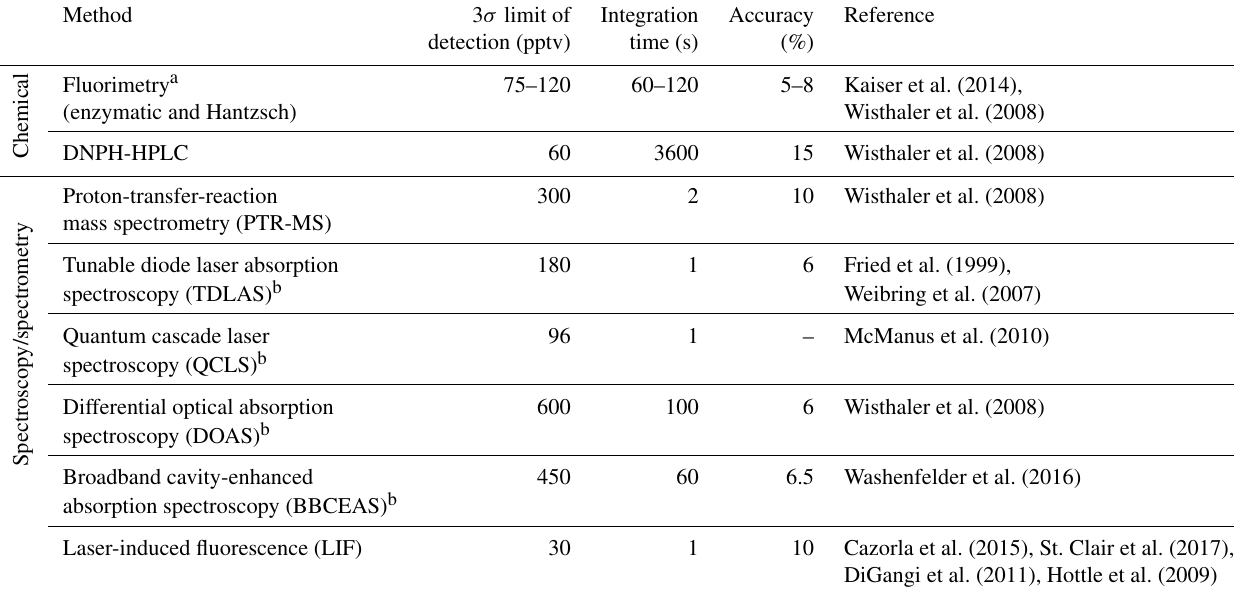
Table 1. Overview of selected in situ HCHO measurement techniques.